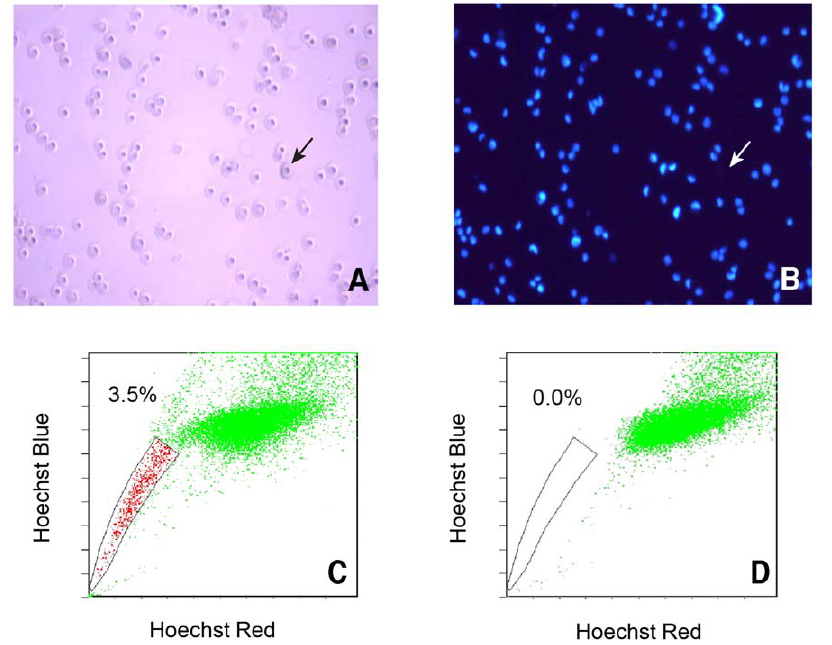
Figure 1. SP analysis in cultured H460 lung cancer cells. A–B, Hoechst staining of H460 cells. Note that although the majority of cells were stained in the nucleus, some cells (indicated by arrows) apparently lacked nuclear Hoechst staining. C–D, SP phenotypes in the absence (C) or presence (D) of verapamil.